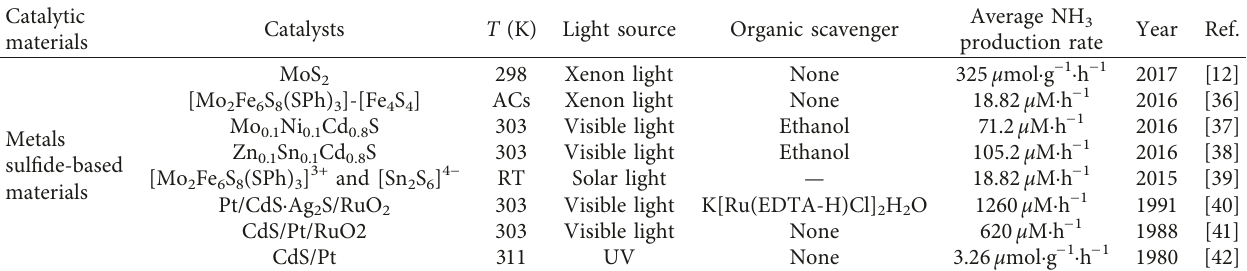
Table 3: Summary of metal sulfide-based materials for photocatalytic reduction of N